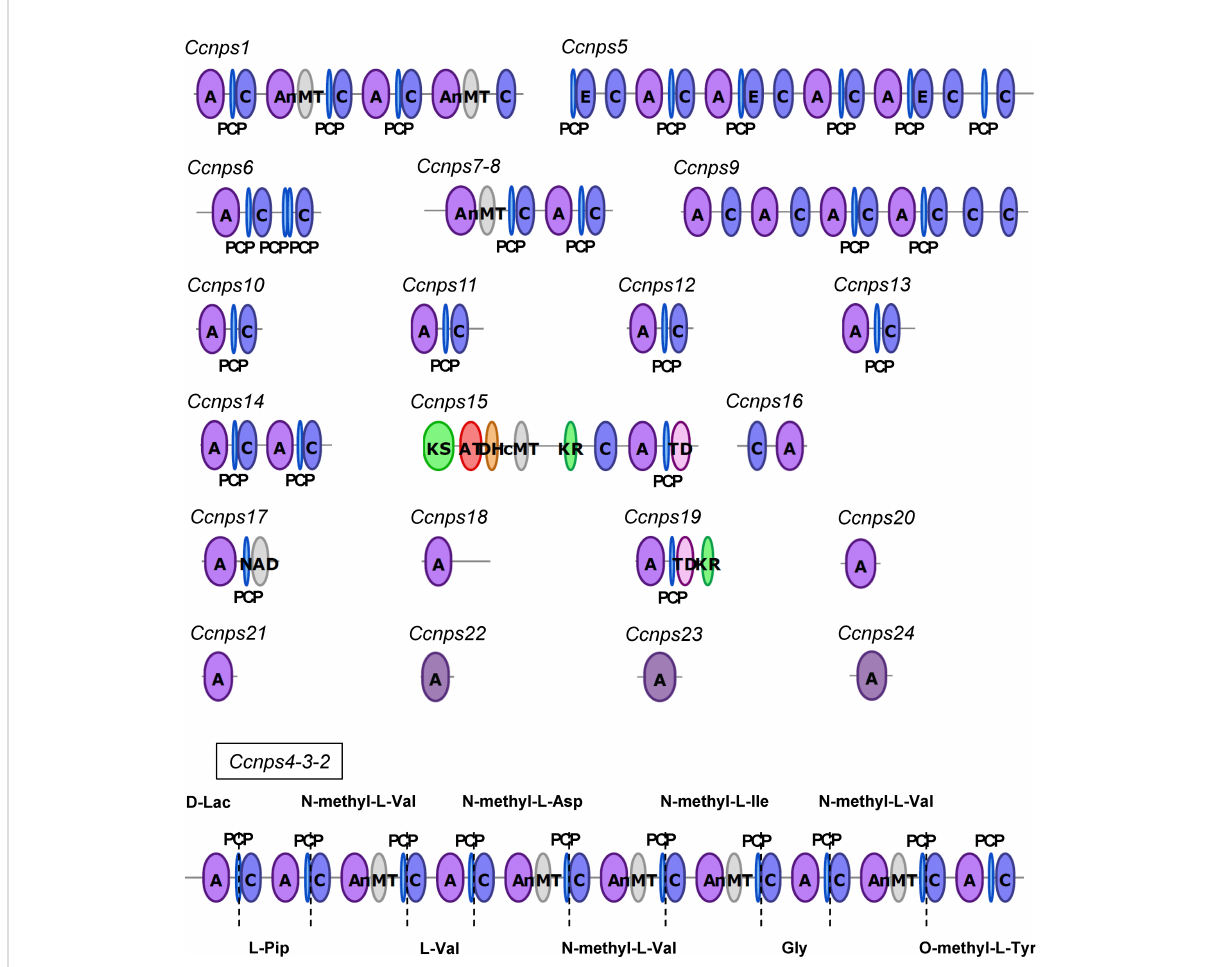
FIGURE 2 The domain structure of each non-ribosomal peptide synthetase that is possessed by Curvularia clavata BAUA-2787, which was deduced by antiSMASH: C, condensation domain; A, adenylation domain; PCP, peptidyl carrier protein domain; nMT, nitrogen methyl transferase; E, epimerization domain; KS, ketosynthase domain; AT, acyltransferase domain; DH, dehydratase domain; cMT, carbon methyltransferase; KR, ketoreductase domain; TD, terminal reductase domain; NAD, male sterility protein. Only the modular structure of NRPS that is encoded by Ccnps4-3-2 is consistent with the structural characteristics of